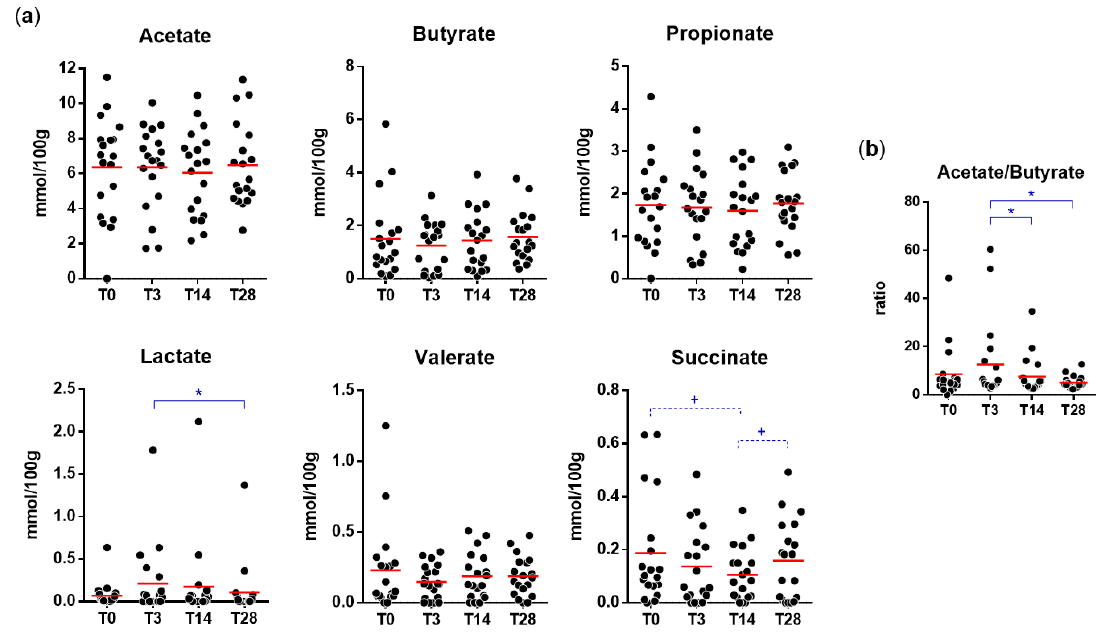
Figure 5. Concentration of short-chain fatty acids, lactate, and pyruvate in fecal samples collected during the trial. Statistically significant differences are according to a paired Student’s t-test (* p < 0.05; +, p between 0.05 and 0.1). ( a ) absolute concentration; ( b ) acetate/butyrate ratio.